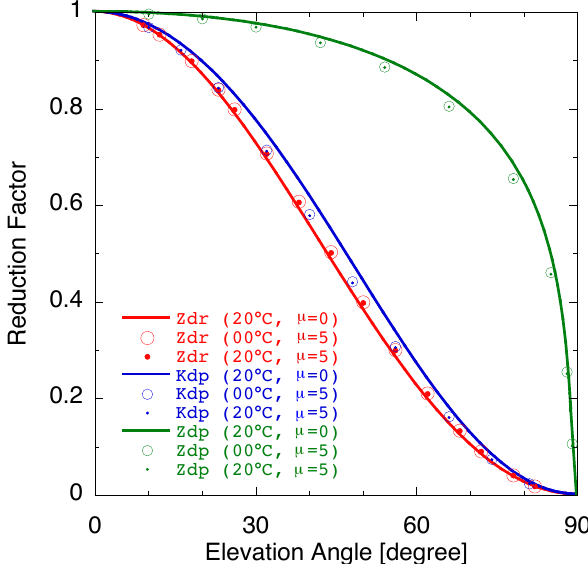
Fig. 4. Differential reflectivity ( Z DR ), specific differential phase ( K DP ) and difference reflectivity ( Z DP ) as a function of elevation angle at raindrop temperatures of 0 and 20 ◦ C with shape parame- ters ( µ ) of 0 and 5 for a modified gamma distribution with an axis ratio of Brandes et al. (2002) and a median volume diameter ( D 0 ) of